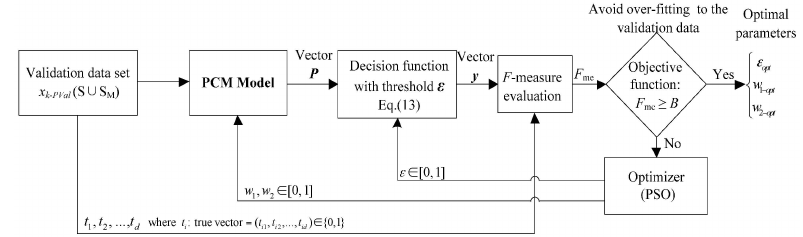
Figure 5. Procedure for optimization of committee member weights and decision threshold.